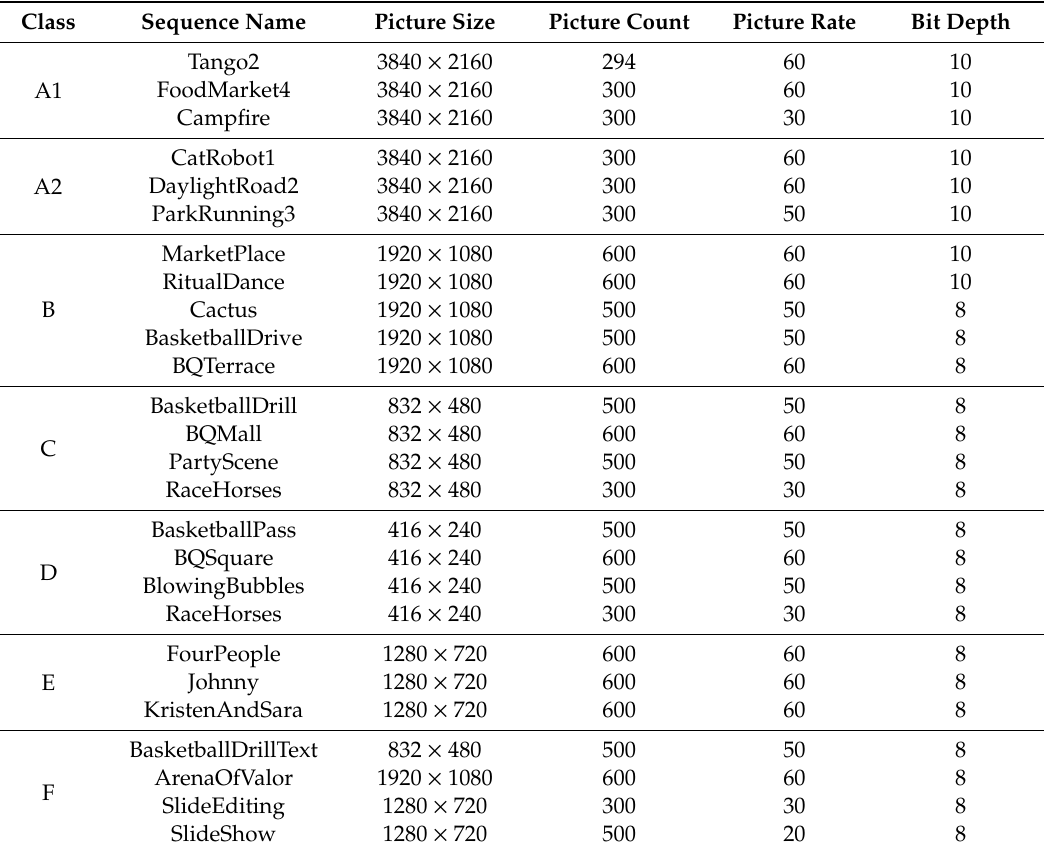
Table 5. Information on video sequences for each